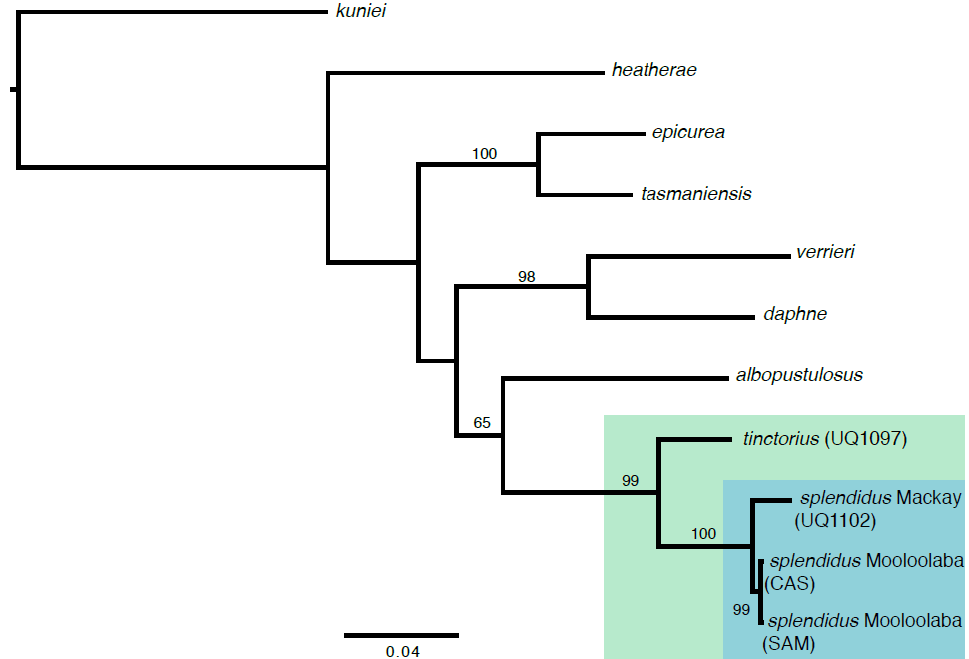
Figure 2. Maximum-likelihood topology for Cytochrome Oxidase I gene (COI) + 16S DNA from selected species of Goniobranchus nudibranchs. Specimens of G. splendidus shown in blue box, and sister species G. tinctorius shown in green box. Bootstrap values less than 60 are not shown.